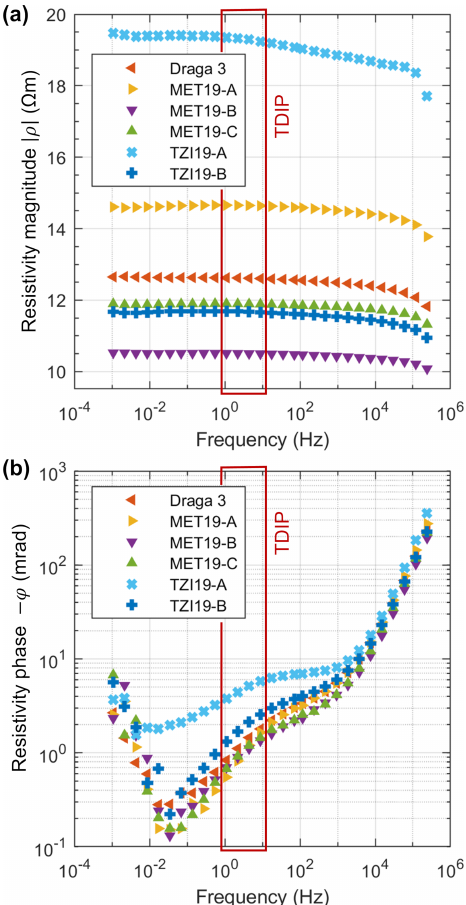
Figure 3. Frequency-dependent complex resistivity of six lake- bottom sediment samples retrieved from Lake Metzabok (triangles) and Lake Tzibaná (crosses). Complex-resistivity values are given in terms of (a) magnitude and (b) phase. The highlighted frequencies between 1 and 10Hz roughly correspond to the range tested by our time-domain induced polarization measurements in the